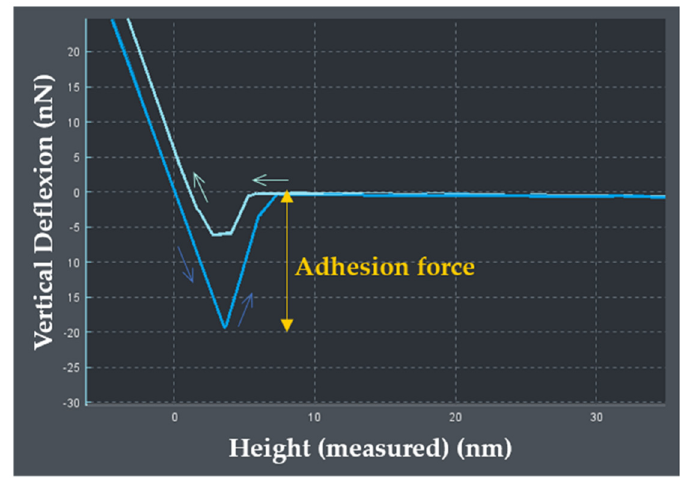
Figure A4. Degradation behavior of the LbL films upon immersion in PBS and in PBS enzymatic solution for 28 days at 37 °C. ( a ) Weight loss percentage as a function of time; ( b ) final weight loss percentage. Significant differences were found for p < 0.05 (*) and p < 0.01 (**).